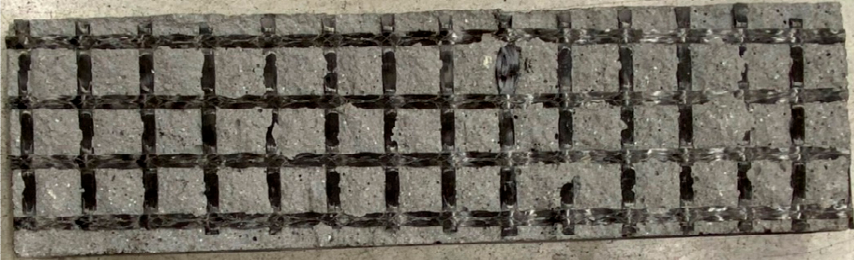
Figure 9. Test specimen of SPP10 series after the covering layer spalled off after the fire experiment (no direct exposure of the reinforcing layer during fire test occurred).